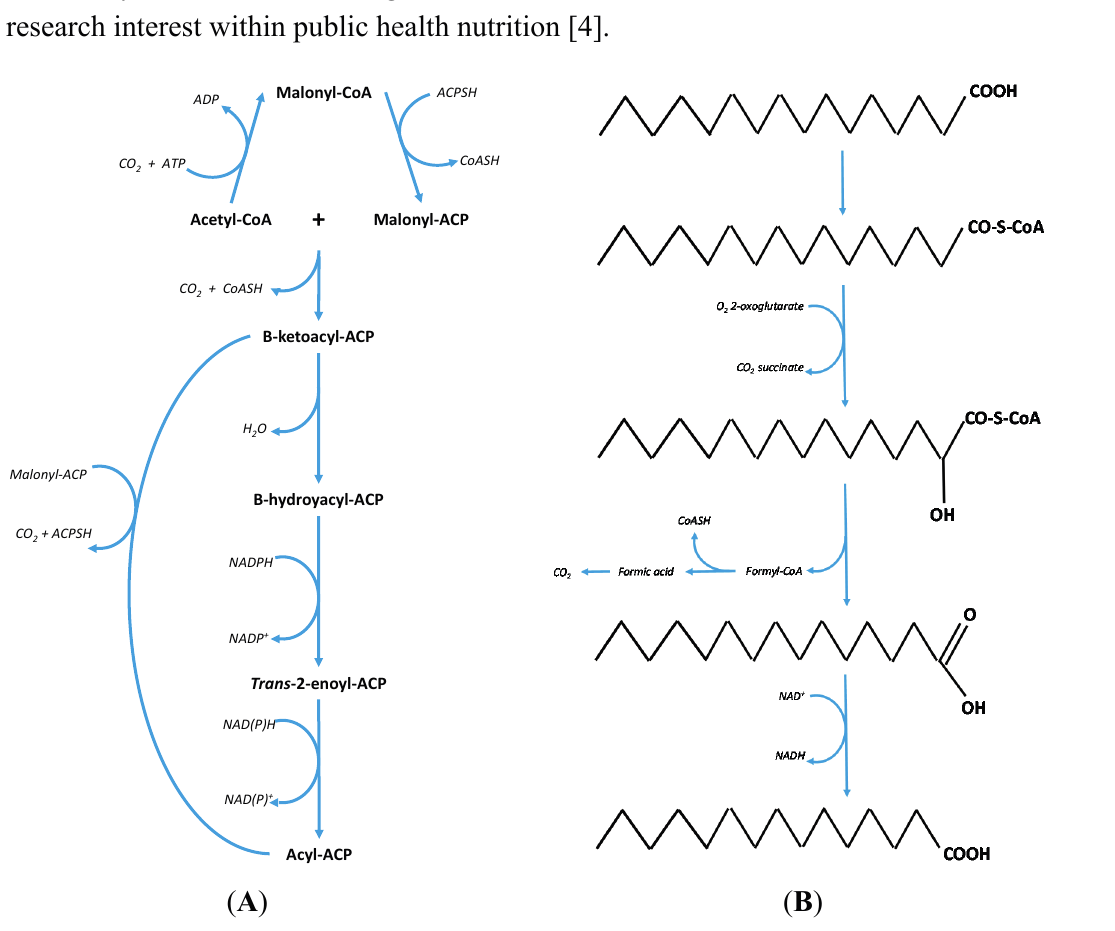
Figure 1. ( A ) On the left—the bacteria bio-synthesis pathway for the production of the fatty acids, C16:0 and C18:0 through the repeated condensation of malonyl CoA with acetyl CoA [19]. ( B ) On the right—the fundamental processes of α -oxidation where the removal of one carbon produces an odd chain fatty acid